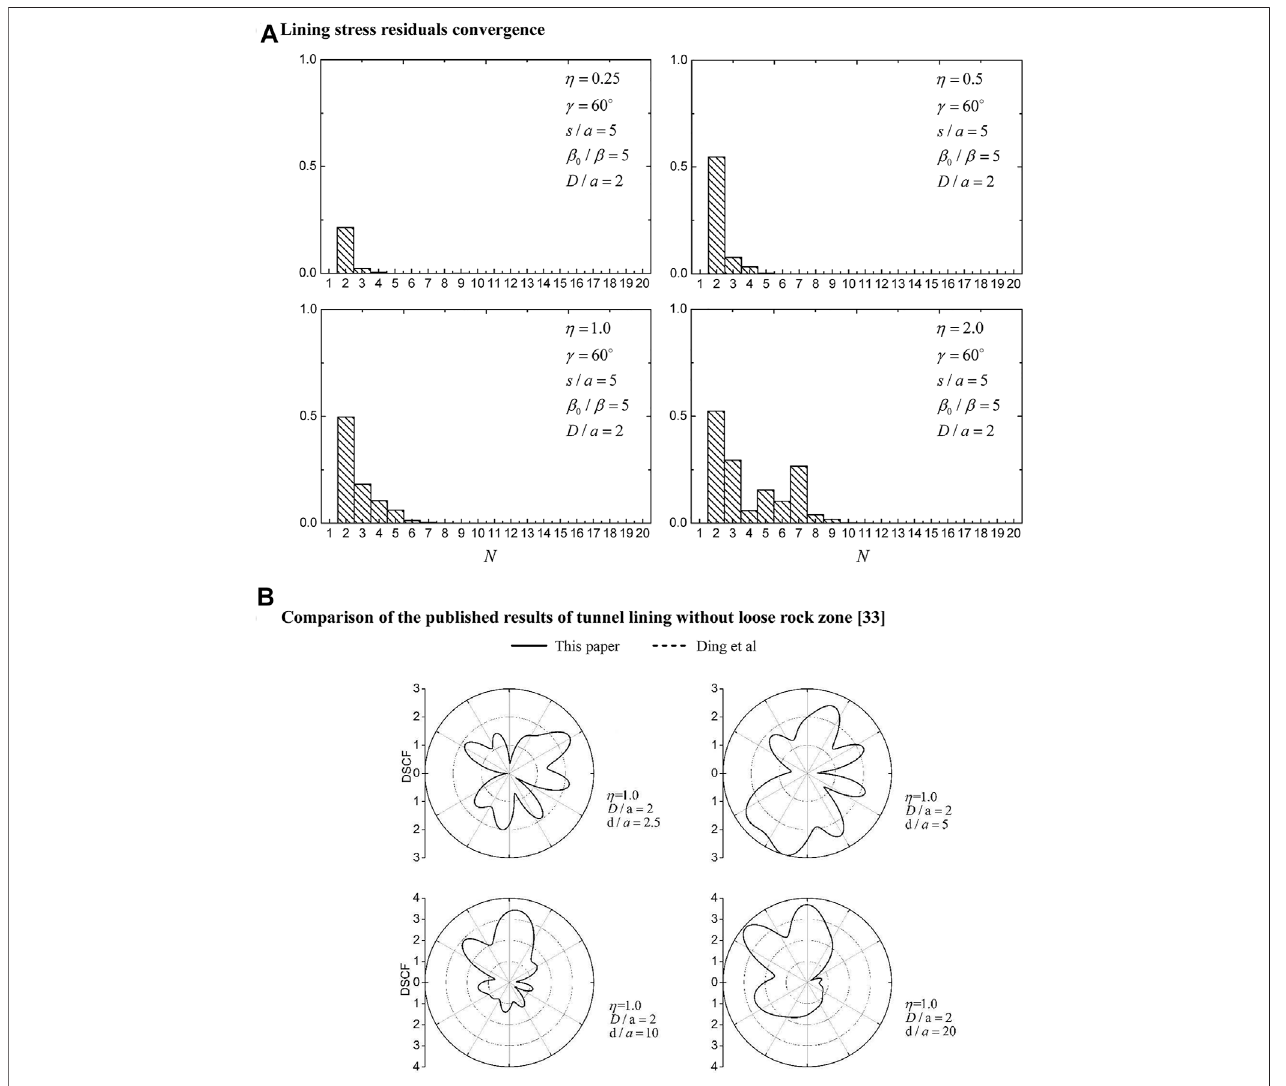
FIGURE 2 | Model veri fi